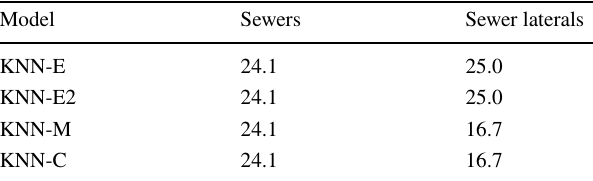
Table 3 Classification accuracy (%) of damages—KNN method